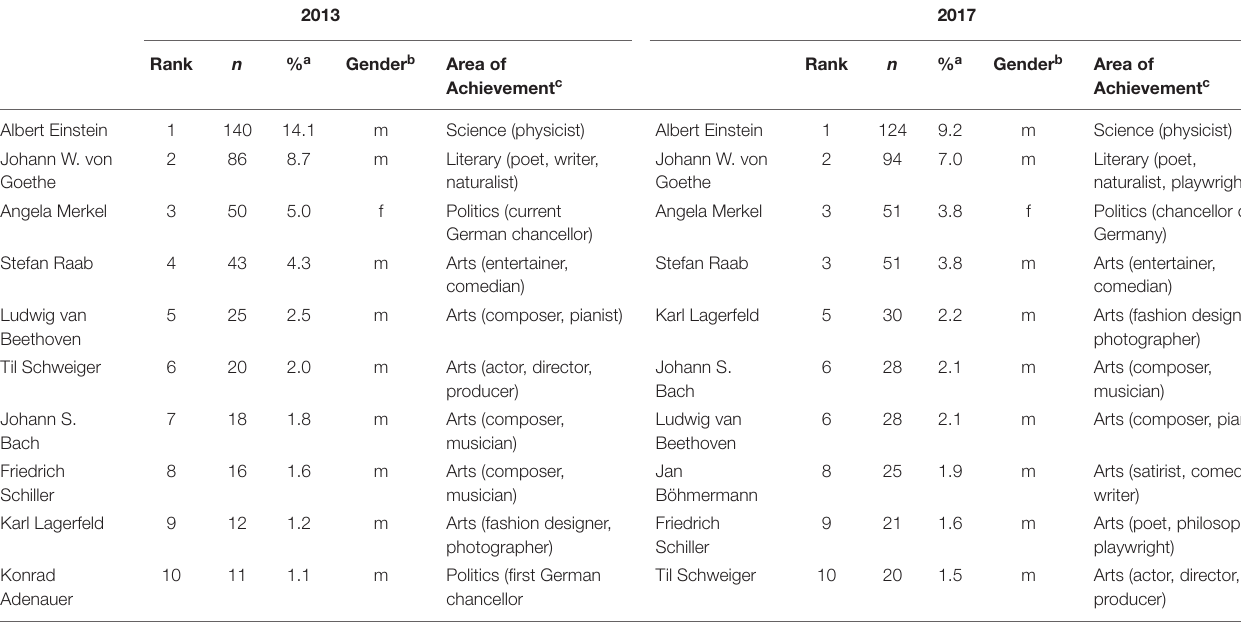
TABLE 1 | The top 10 ranks of the most creative persons from Germany in 2013 and 2017.